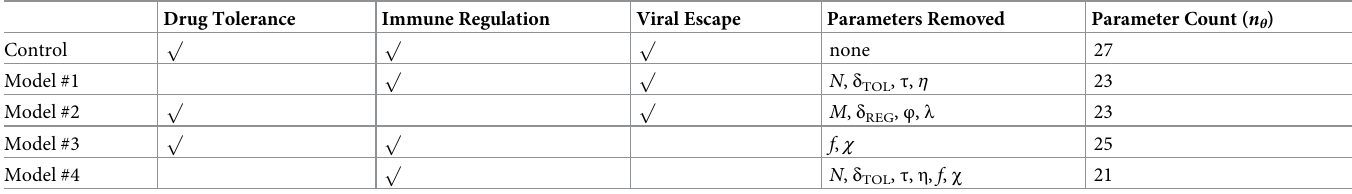
Table 4. Summary of models